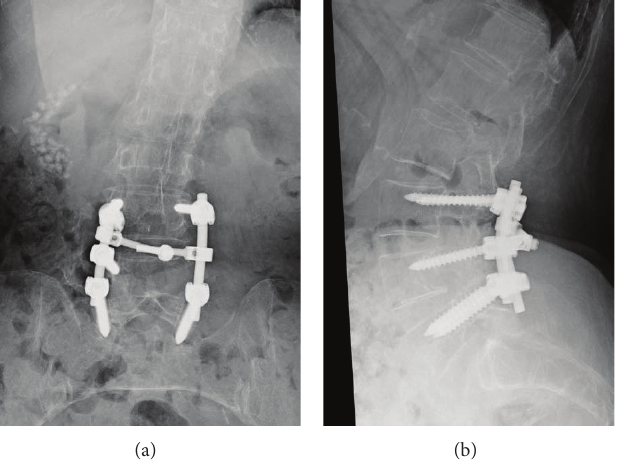
Figure 2: Removal of the tumor and posterolateral fusion was performed. (a) Anteroposterior view, and (b) lateral view.